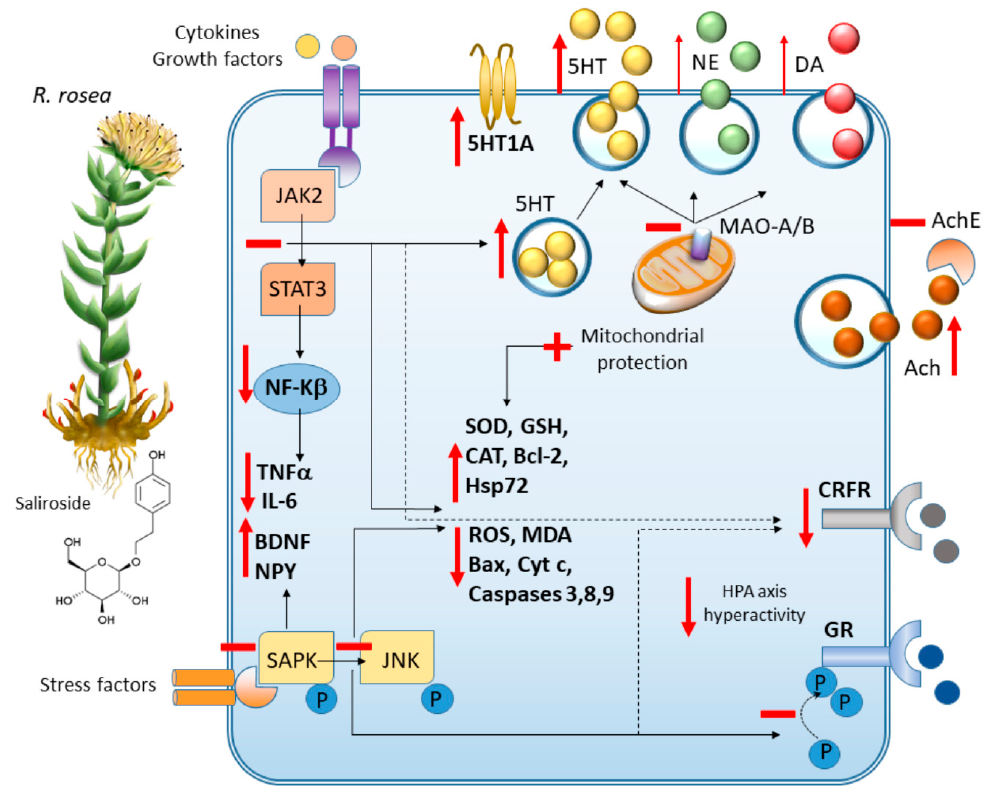
Figure 5. R. rosea: molecular mechanisms underlying neuroprotective, cognitive enhancing and